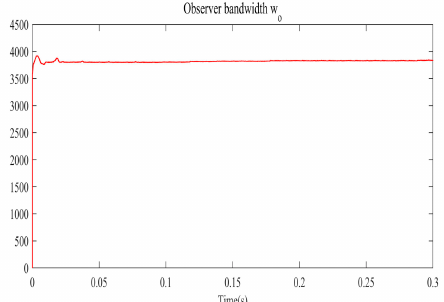
Figure 8. Learning curve of IT2FNN for observer bandwidth o